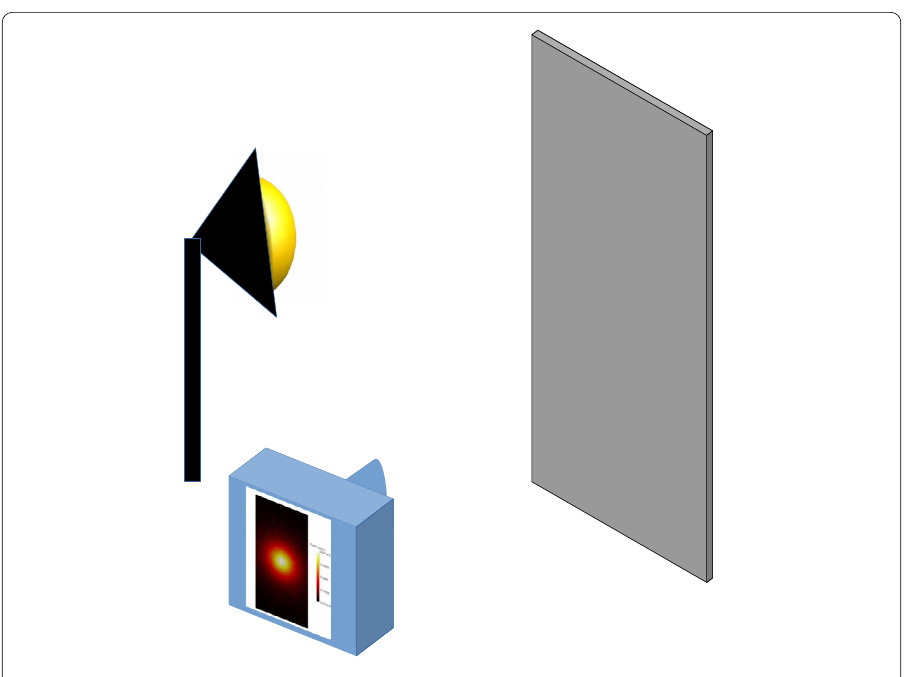
Figure 1 Experiments setup. Both the camera and the lamp are situated at the same side of the inspected